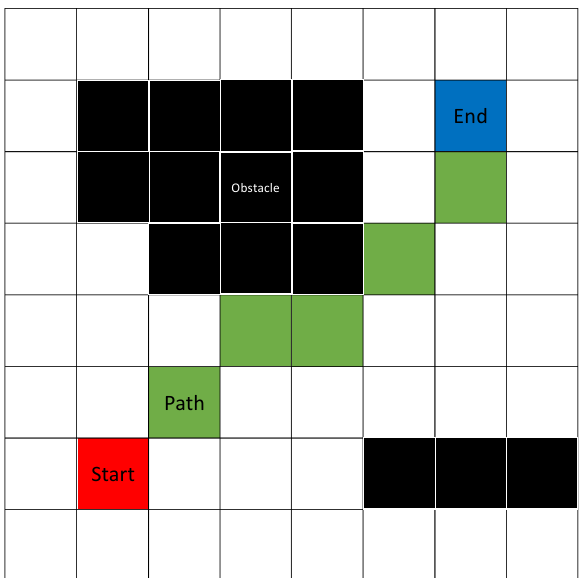
Figure 2. Grid world representation. Cells with a value of [0,0,0] (black) are obstacles, while cells with [255,255,255] (white) can be traversed. Red [255,0,0] and blue [0,0,255] cells are, respectively, starting and ending positions, while green [0,255,0] cells represent path